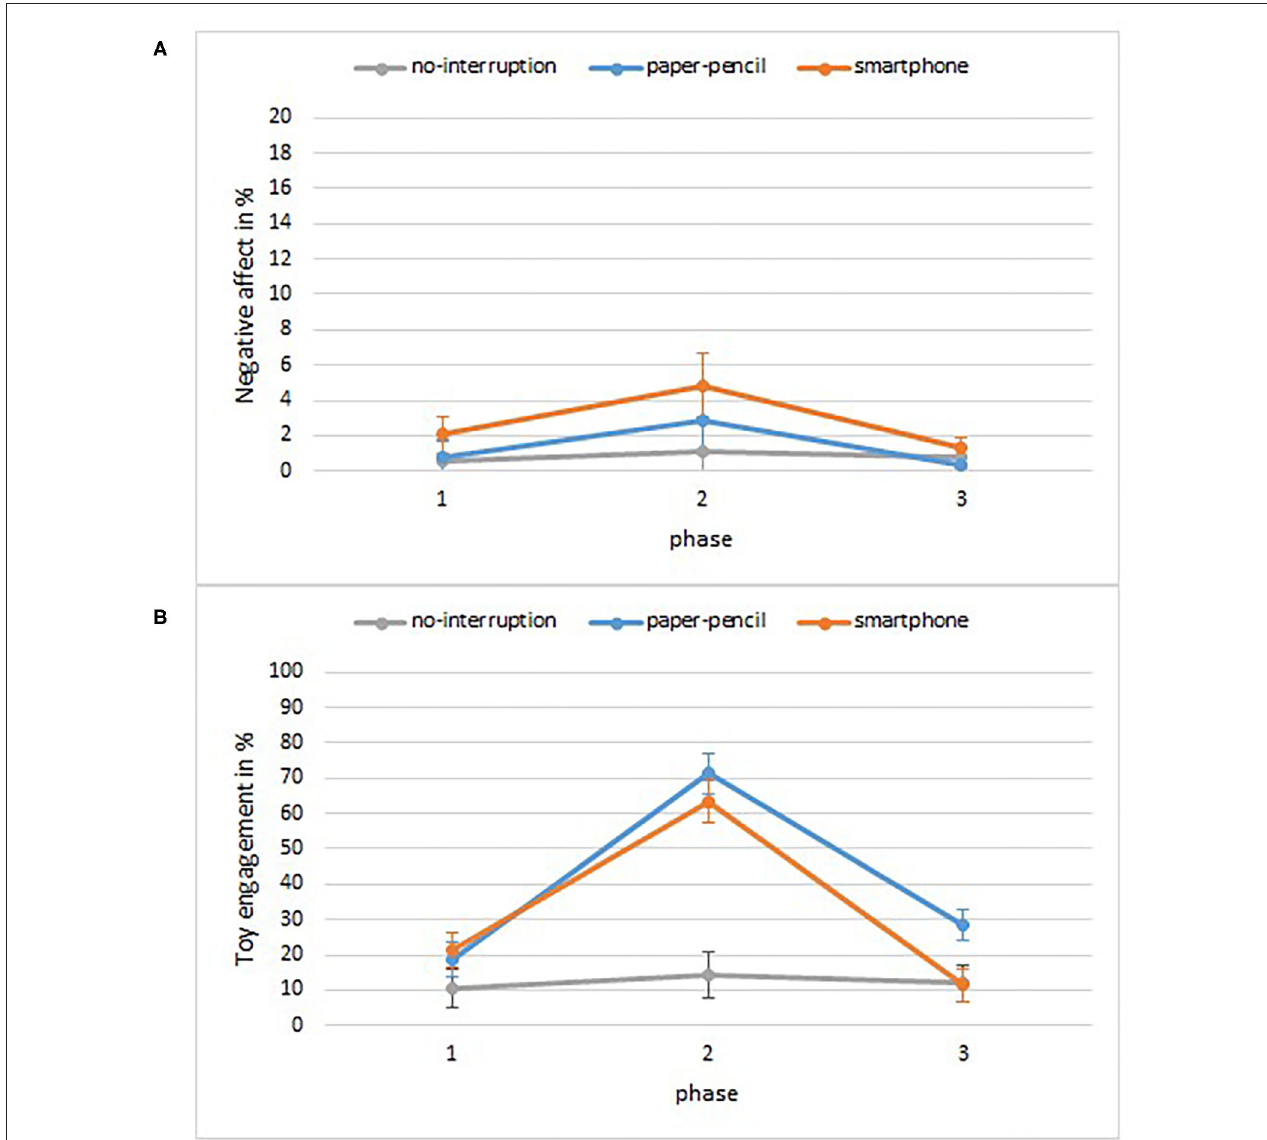
FIGURE 4 | Child behaviors as percentage of the time as a function of phase and condition. (A) Negative affect, (B) toy engagement. Error bars are SE of